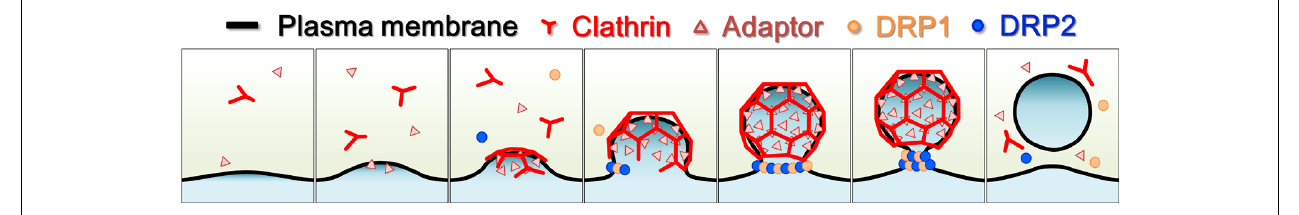
FIGURE 4 | Schematic illustration of endocytic clathrin-coated vesicle formation in land plants. Light yellow, cytosol; black line, plasma membrane; red, clathrin and clathrin coat; pink triangles, clathrin adaptors; orange dots, DRP1; blue dots, DRP2.